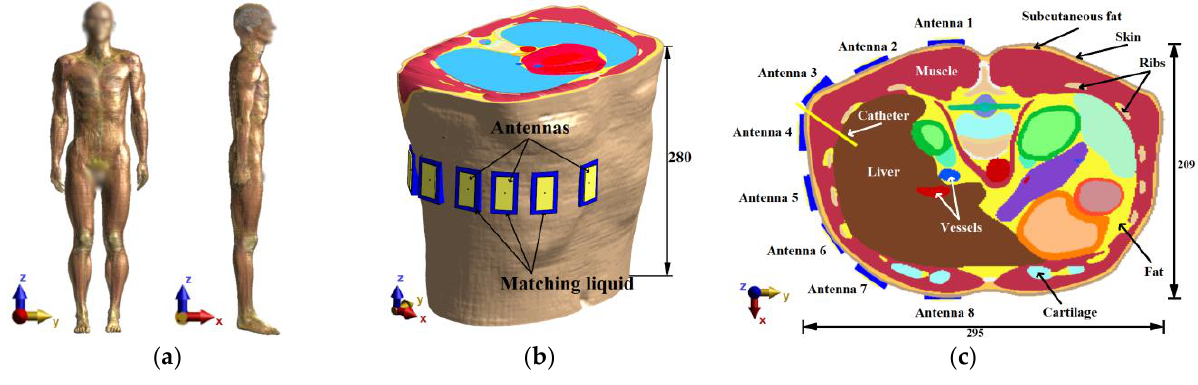
Figure 3. Heterogeneous model: ( a ) Duke patient’s model; ( b ) Model with placed antennas; ( c ) Imaging plane with antenna layout and description of essential structures. All dimensions are expressed in mm. The values of the dielectric parameters for the central frequency f c of the considered UWB pulses were assigned from the IT’IS Database [34] to the model domains corresponding to individual tissues. For completeness, these values are listed in Table 1. Table 1. Dielectric parameters of materials and tissues used in numerical models, taken from